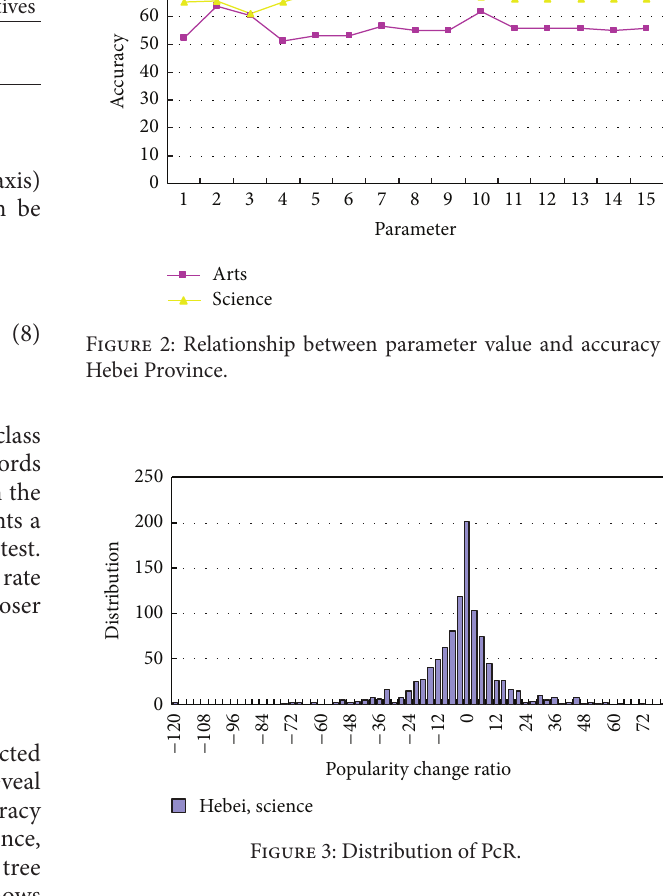
Table 2: Confusion matrix representation. Predicted positives